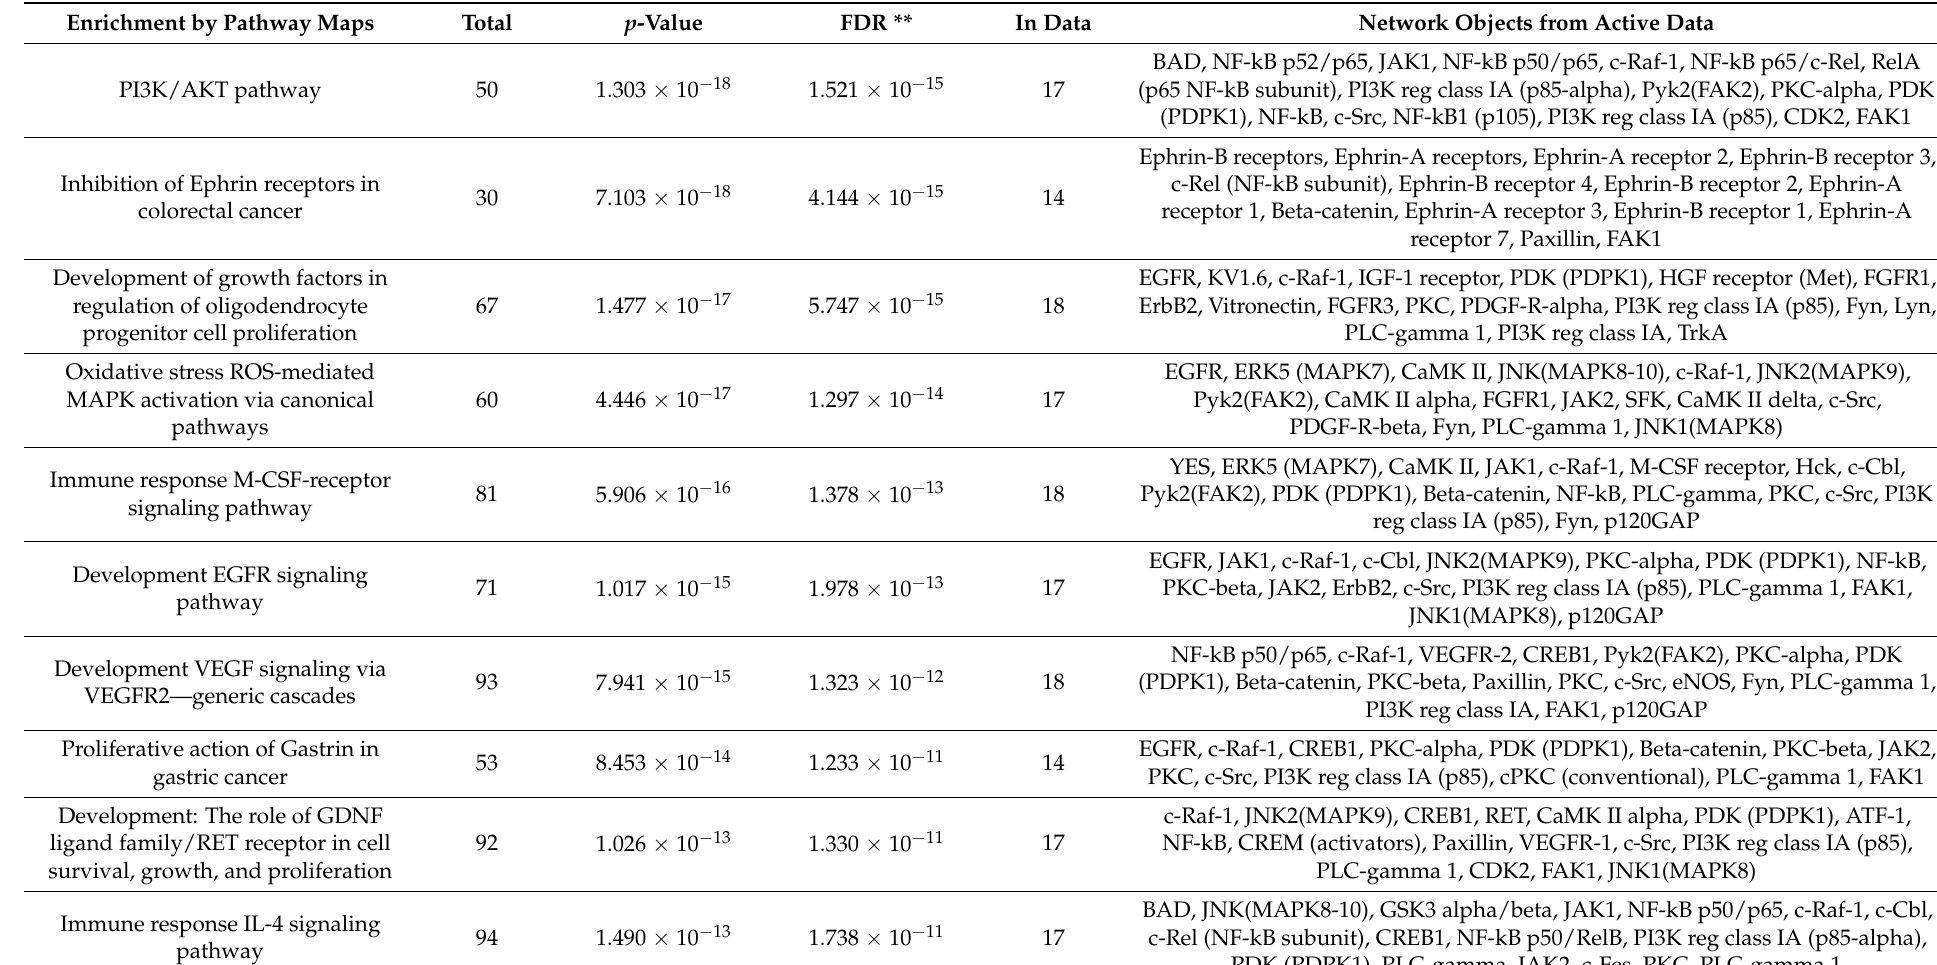
Table 2. Top ten enrichment pathway analysis * of the Saudi CRC samples.